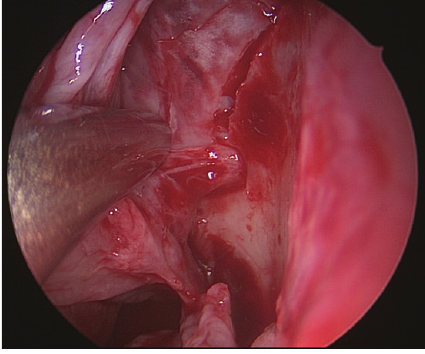
Figure 1: Endoscopic exposure of the left sphenopalatine artery.